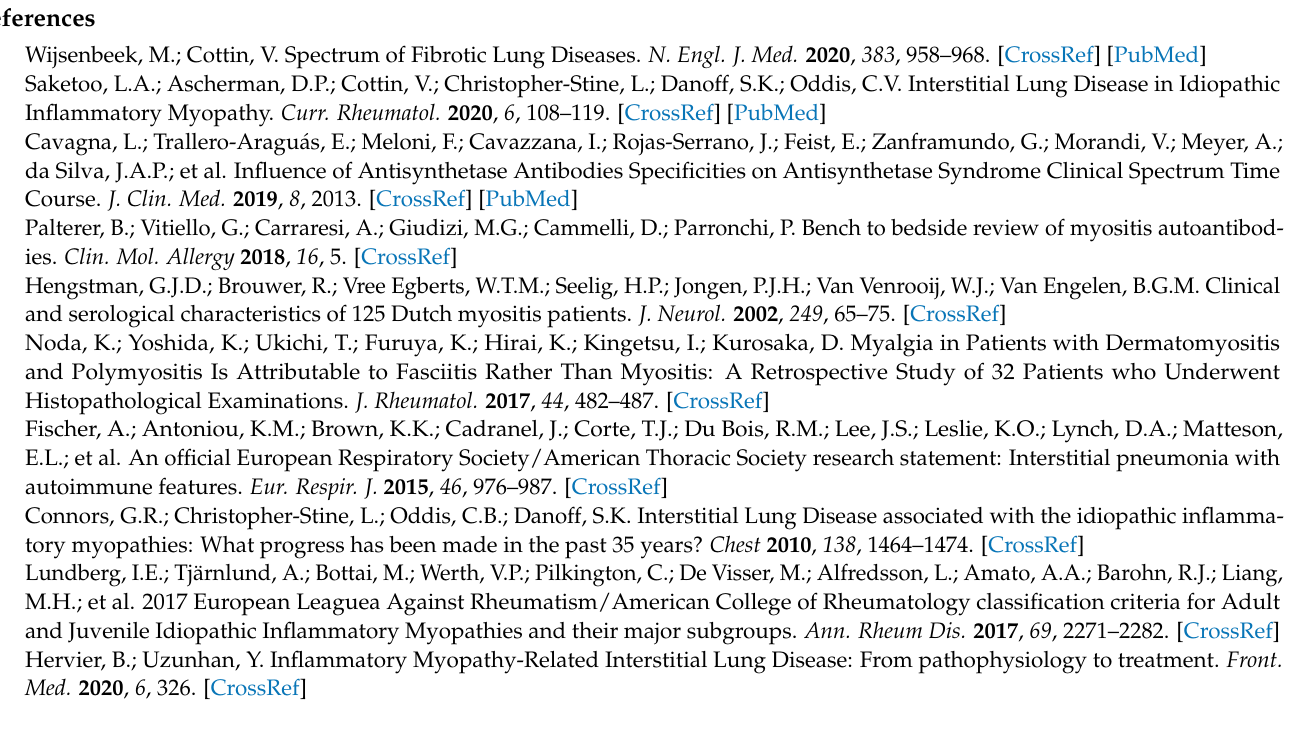
groups studied; Table S2: Patients with multiple MSA/MAA positivity; Table S3: Diagnoses in ILD patients; Table S4: Diagnoses in ILD patients with increased level of muscular enzymes; Table S5: Diagnoses in ILD